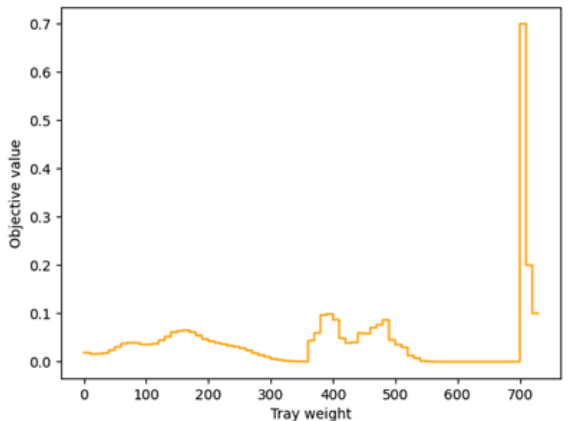
Figure 7. An example of a profit function.